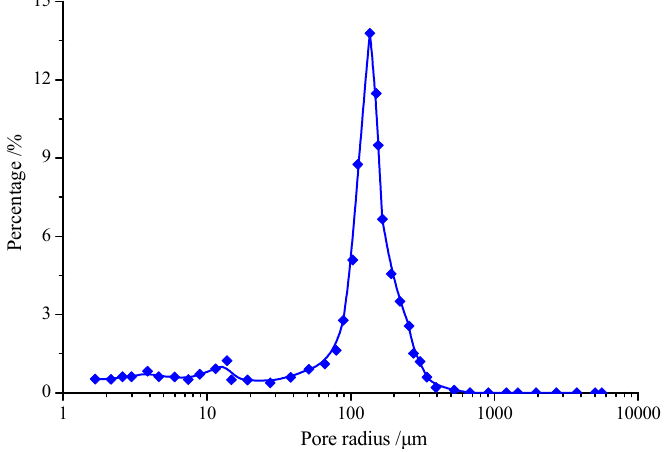
Figure 1. Pore radius distribution map. The pore radius is mainly concentrated in the 60–300 µ m interval and relatively uniform.